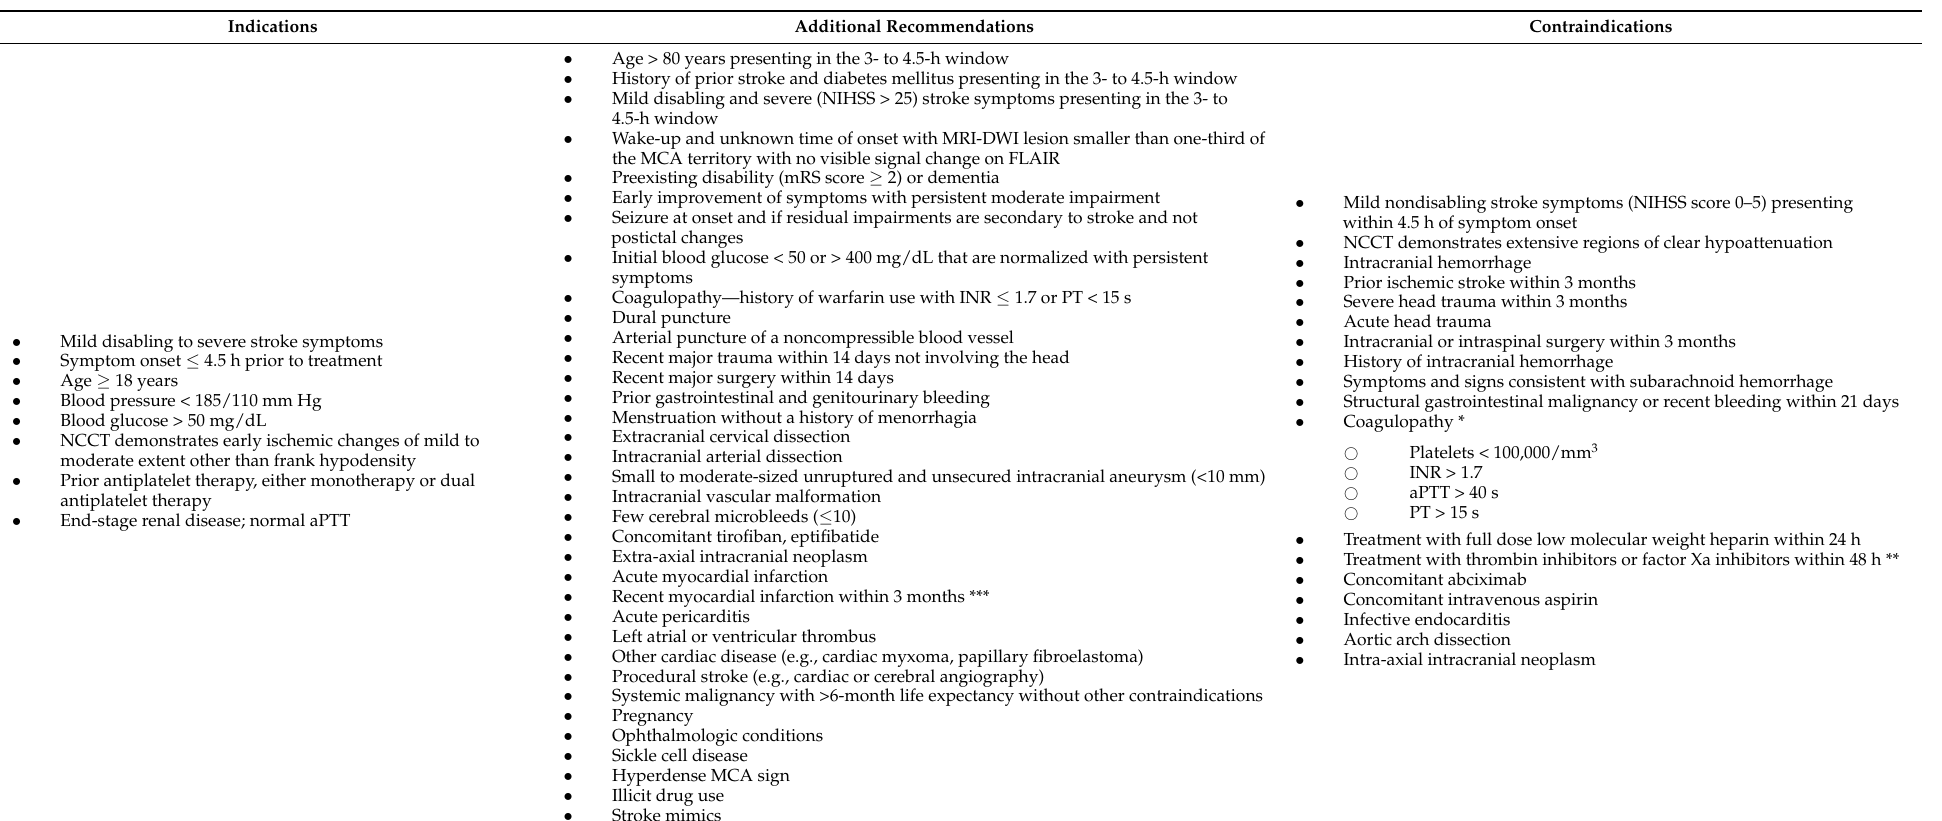
Table 3. Indications and Contraindications of Intravenous Recombinant Tissue Plasminogen